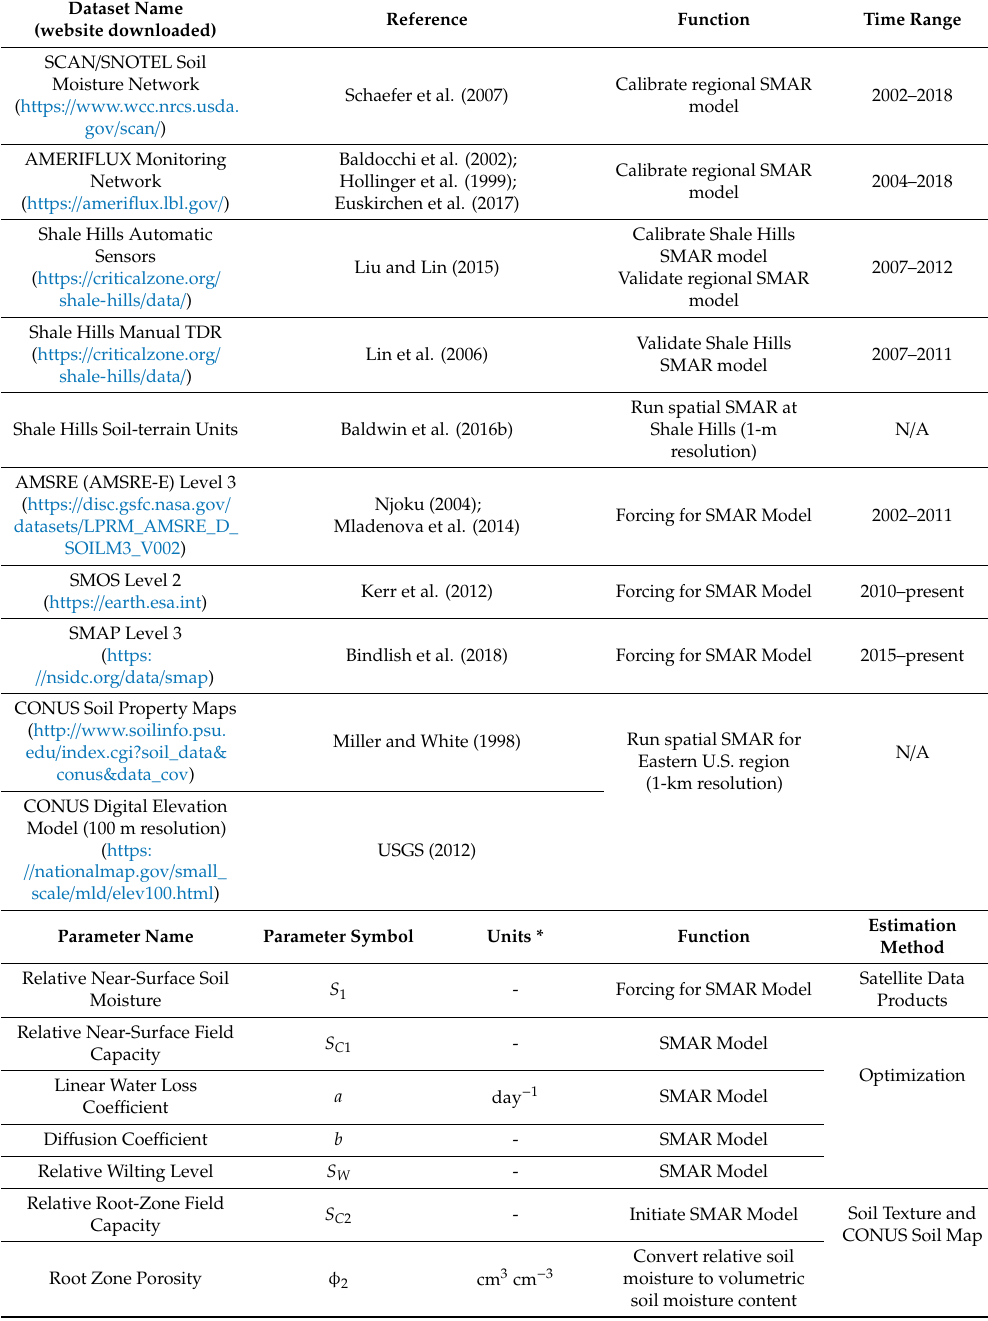
Table 1. List of all datasets and model parameters used in this